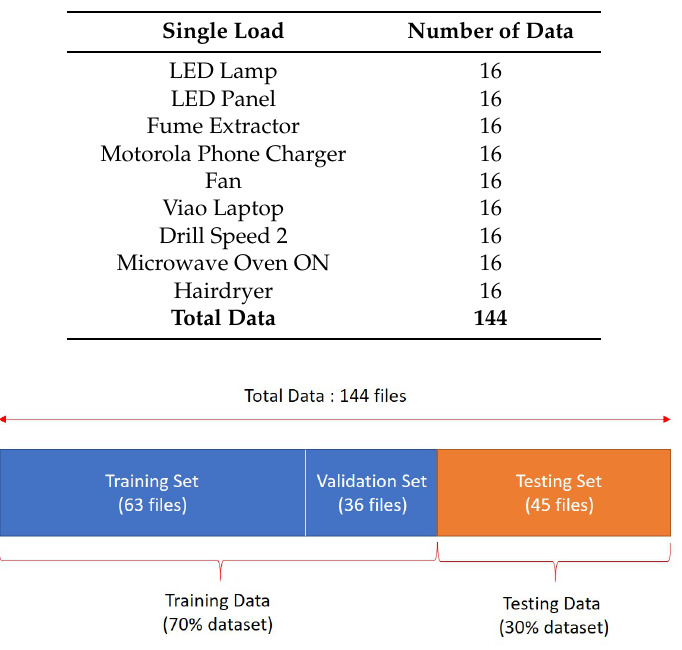
Table 2. Number of single load data.